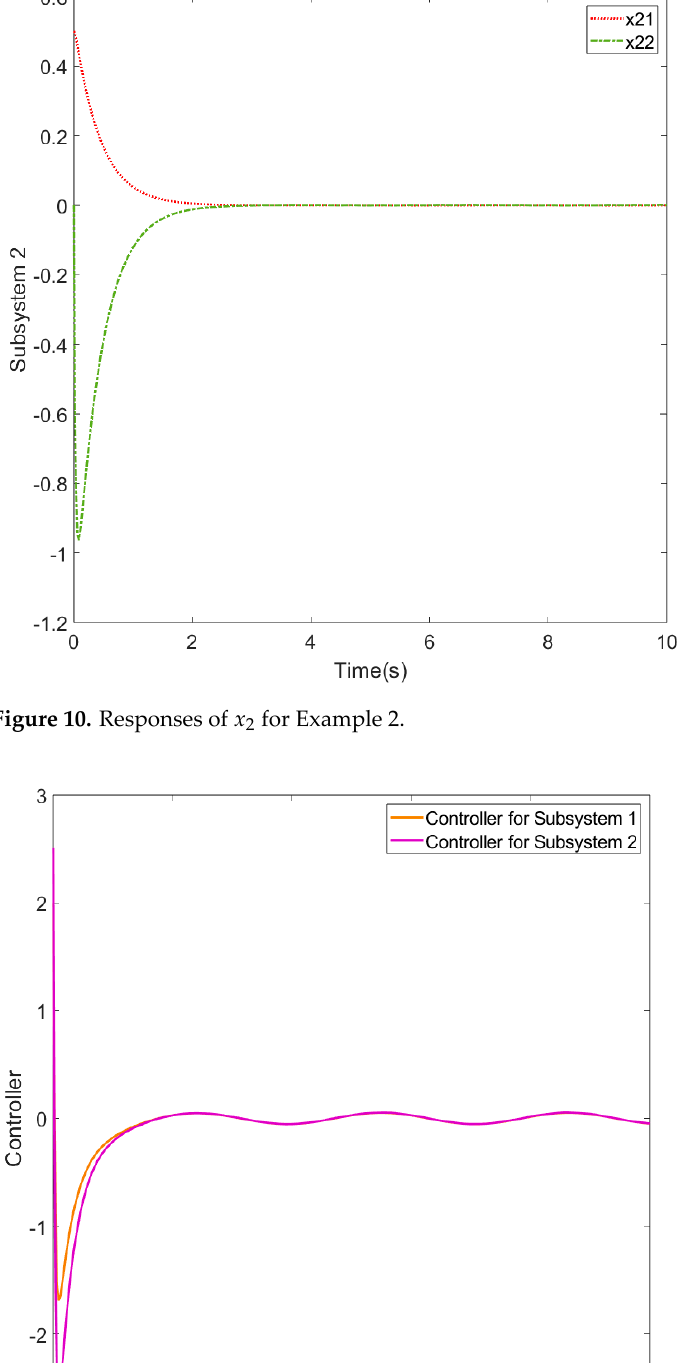
Figure 11. Control signals for Example 2.